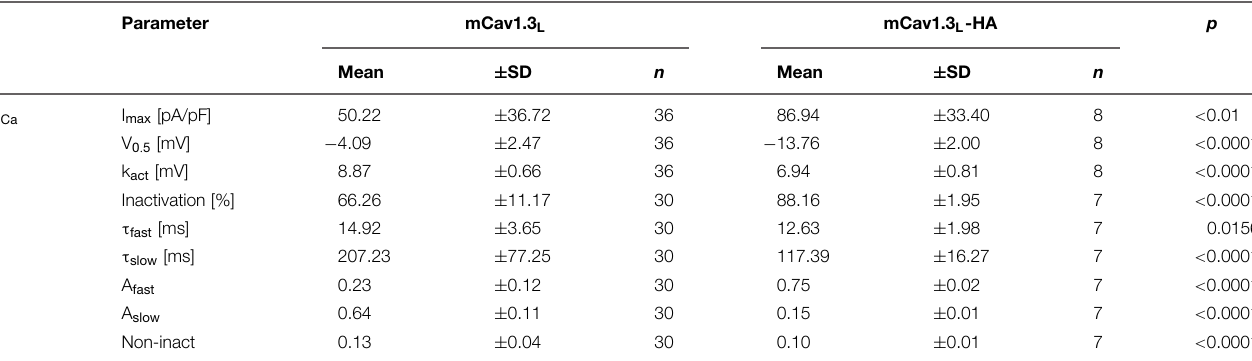
TABLE 1 | Biophysical properties of mCav1.3 L and mCav1.3 L -HA. Parameter